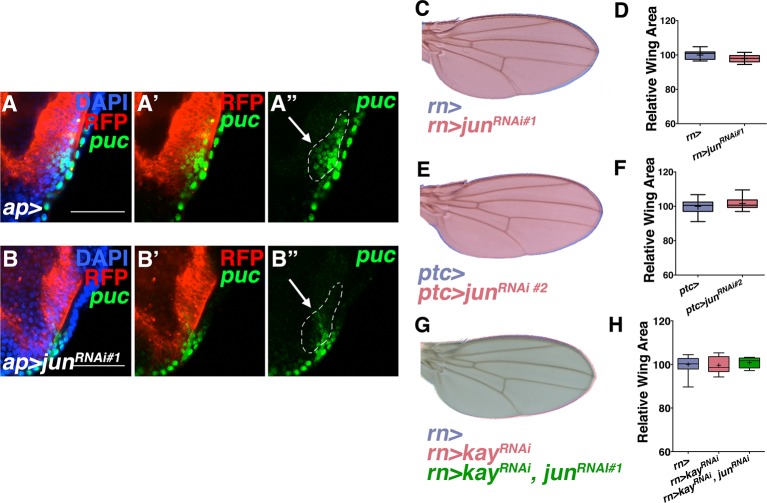
Jun RNAi line validation and loss of kayak phenotypes.Related to Figure 3. RNAi-mediated knockdown of Jun in ap domain cells decreases puc expression (puc-lacZ, green) (B) compared to controls (A). Dotted line indicates puc+ cells that co-localize with ap-Gal4. Note decreased puc-lacZ staining in this domain following Jun inhibition. However, (C-D) inhibition of Jun in all wing cells by RNAi-mediated knockdown does not show a phenotype. (E-F) A second Jun RNAi line does not show a phenotype when expressed in ptc-expressing cells. (G-H) Inhibition of kayak/fos (red, rn>kayRNAi) does not affect wing size, nor does inhibiting jun and kay together (green, rn>kayRNAi, junRNAi). Individually, kayRNAi lines induced a thorax closure defect when driven by ap-Gal4. For box plots, whiskers represent maximum and minimum values. Bar: 5DOI: